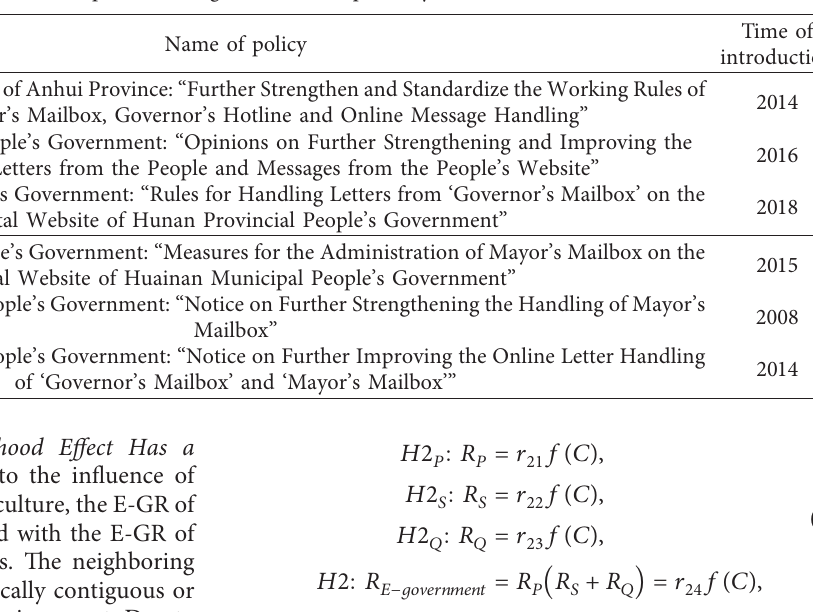
Table 3: Examples of local government response